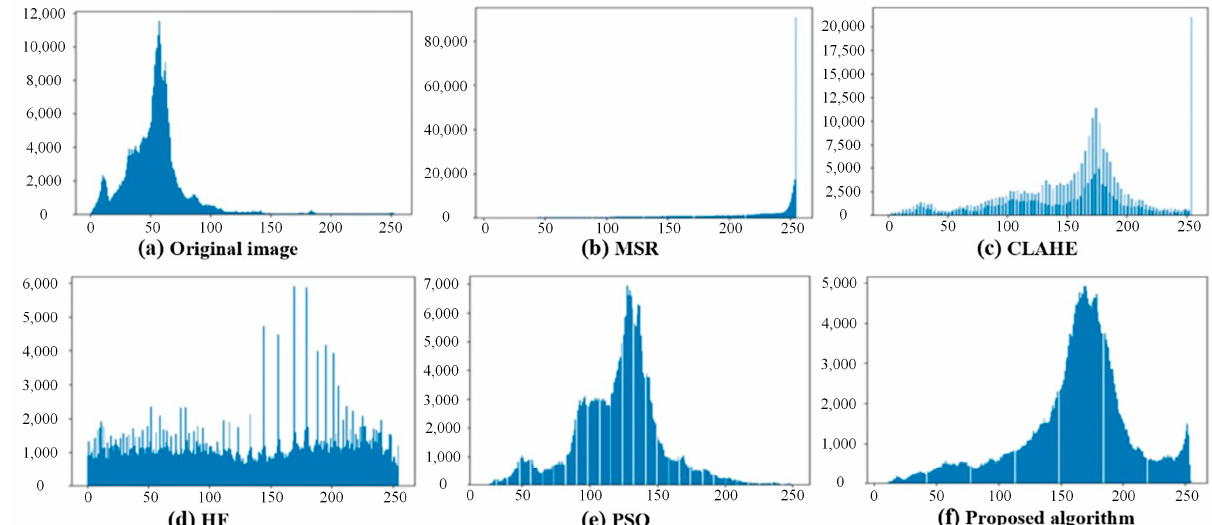
Figure 10. Enhancement histogram of corridor image.